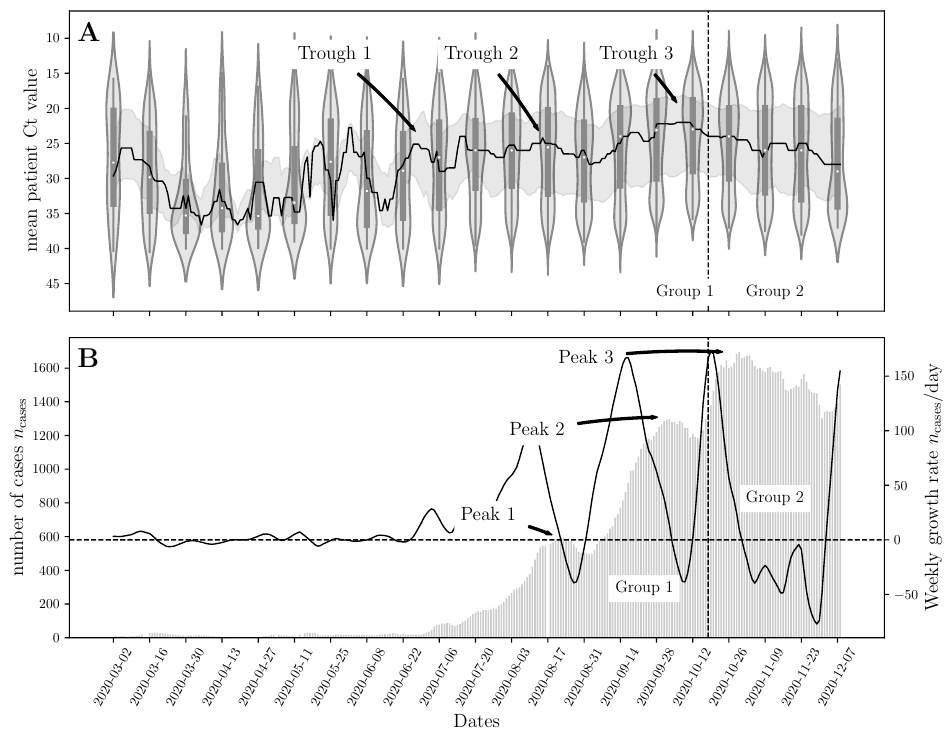
Figure 4. ( A ) Bi-weekly mean Ct values of RHUH patients. The solid line represents the median bi-weekly Ct values, and the gray shaded area represents the inter-quartile range (25–75 percentile) of the observed Ct values. ( B ) The grey bars show the weekly running average of the number of cases observed nationwide in Lebanon between 1 March 2020, and 7 December 2020 (the running average can be computed until 23 November). The solid black line represents the growth rate in the weekly number of